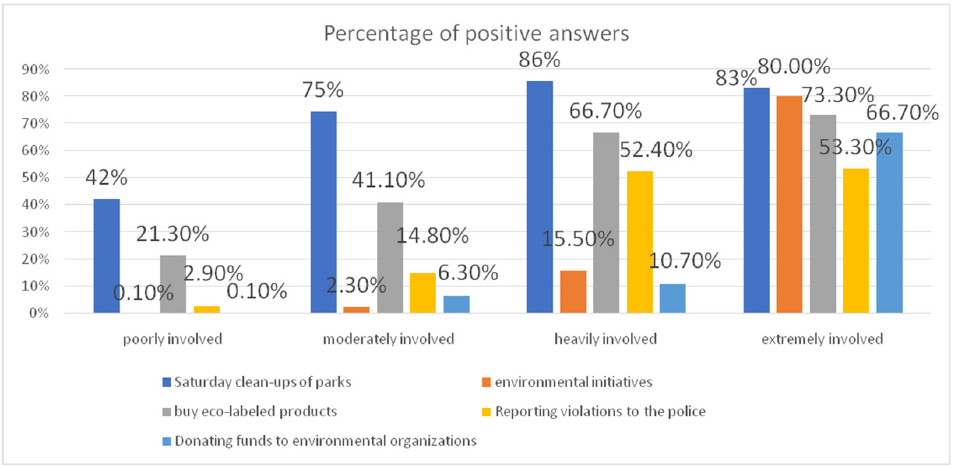
Figure 2. Pro-environmental behaviors of groups.